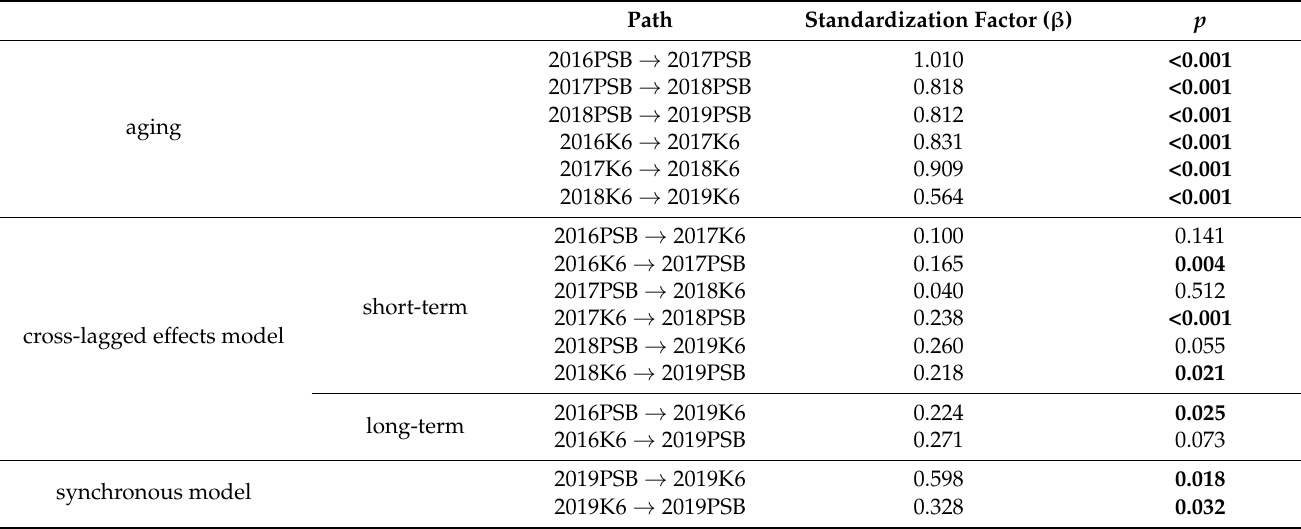
Table 2. Maximum likelihood parameter estimates.